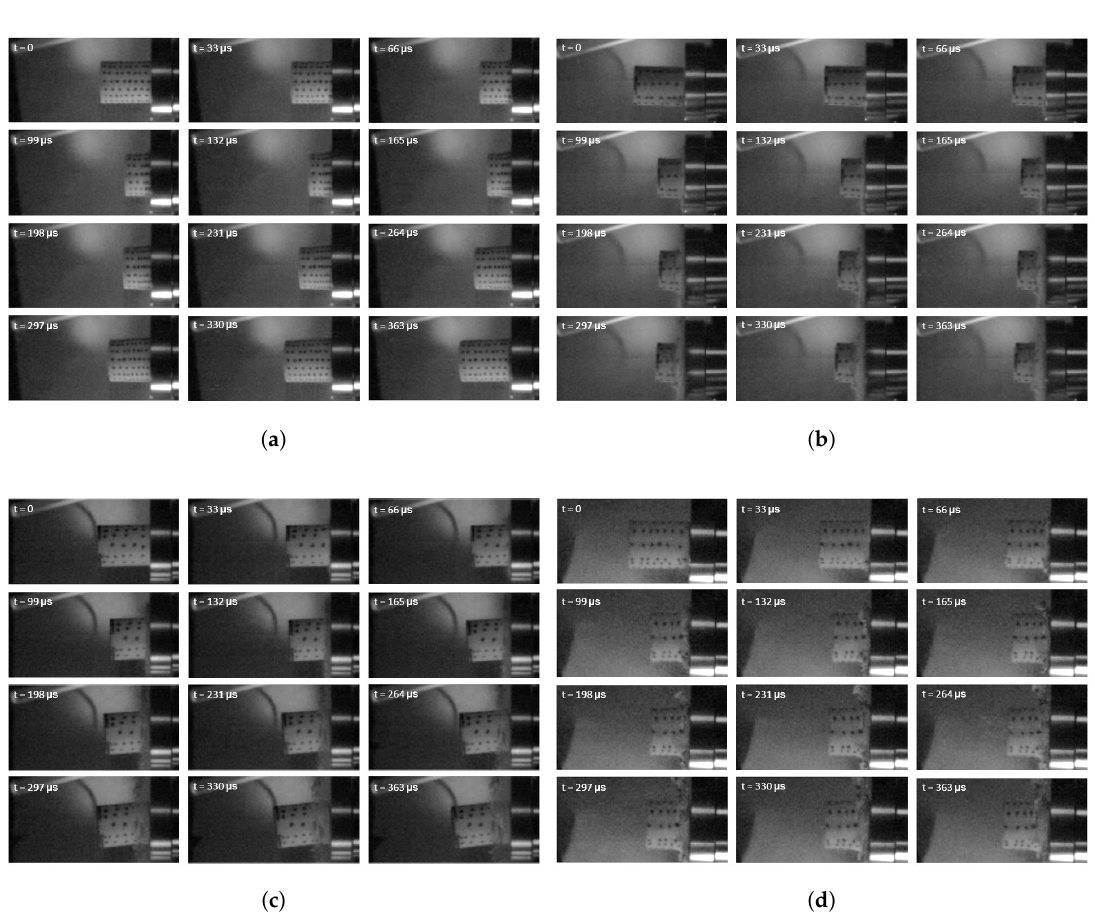
Figure 10. Series of snapshots from dynamic compression tests for selected materials. ( a ) Type G (Plastazote R (cid:13) HD60); ( b ) Type I (PET); ( c ) Type O (Rohacell R (cid:13) 110RIST); ( d ) Type W (3D printed